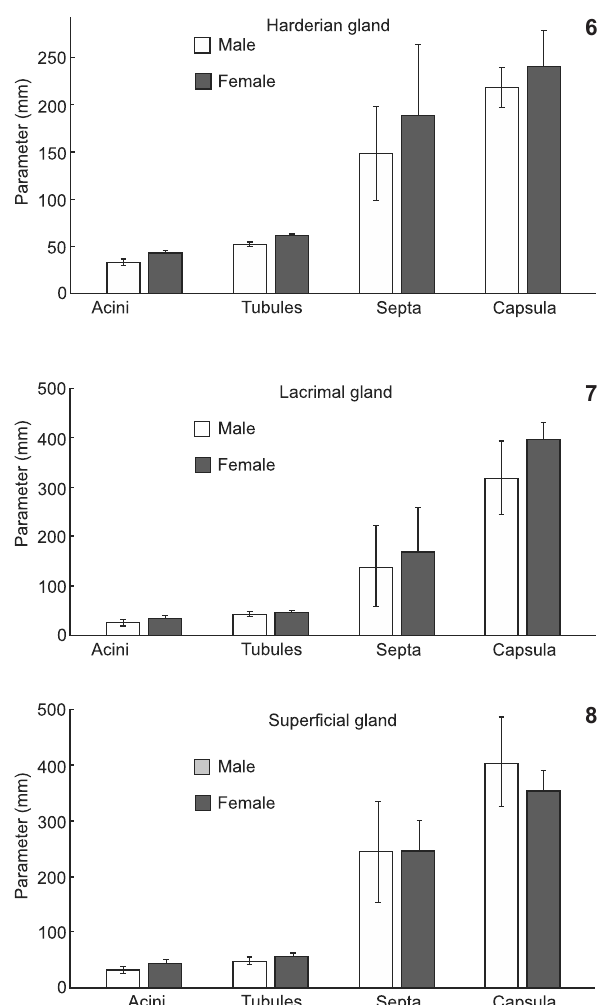
Figures 6-8. Morphometric parameters (µm) of alveoli/acini, tu- bules, interlobular septa and capsule in the HG (6), LG (7) and SGTE (8) of European bison with respect males and females. Val- ues are expressed as mean ± standard